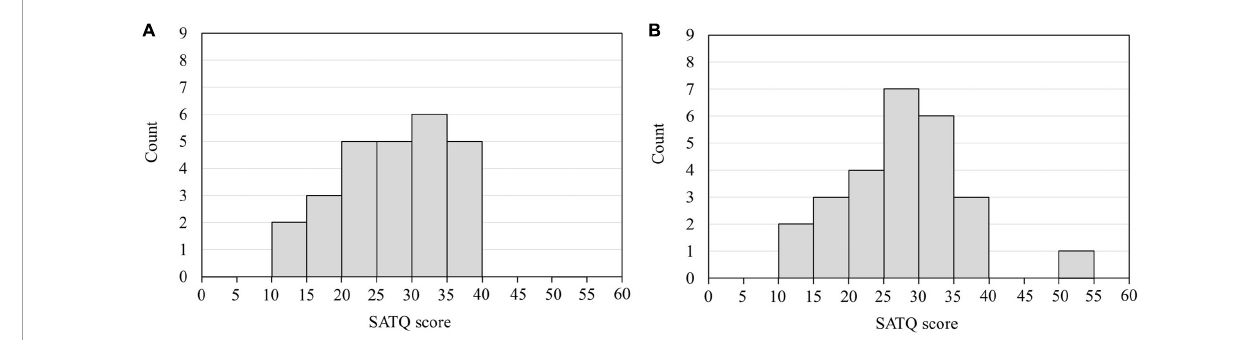
FIGURE2 Histogram of the SATQ scores of 26 participants used in the ERP analysis. The horizontal axis is the SATQ score of each participant, and the vertical axis is the number of participants. (A) SATQ scores of 26 individuals were used to analyze ERPs at the T5 electrode. Four participants whose ERPs could not be identified at the T5 electrode were excluded from the analysis. The mean and standard deviation of the SATQ score in the participants was 26.85 ± 7.21 out of 72 points. (B) SATQ scores of 26 individuals were used to analyze ERPs at the T6 electrode. Four participants whose ERPs could not be identified at the T6 electrode were excluded from the analysis. The mean and standard deviation of the participants’ SATQ score was 27.04 ± 8.13 of 72 points. SATQ, subthreshold autism trait questionnaire; ERP, event-related potential.